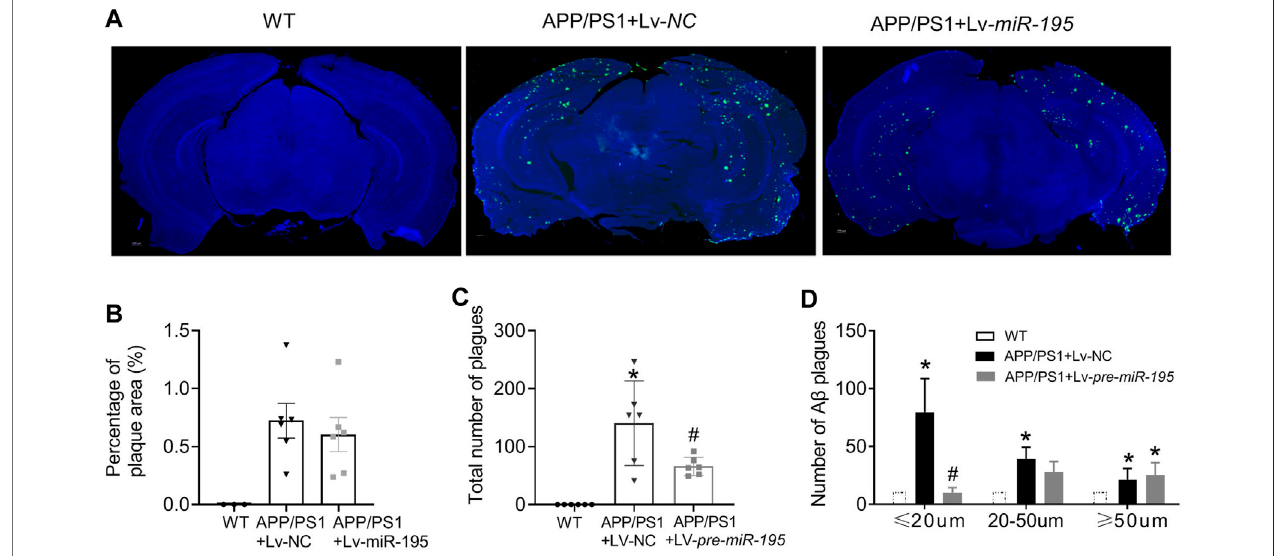
FIGURE 8 | MiR-195 reduces A β plaques in the brain of APP/PS1 mice (A) Representative confocal images showing the deposition of A β plaques in the brain of 7M-old WT mice, APP/PS1 mice with LV-NC injection and APP/PS1 mice with Lv-pre- miR-19 5 injection (B) The percentage ofA β plaquesarea in the brain ofAPP/PS1 mice* p < 0.05vs.WT (C) ThetotalnumberofA β plaquesinthebrainofAPP/PS1micewithbraininjectionofLv-pre -miR-195 for3M.* p < 0.05vs.WT.# p < 0.05vs.Lv- NC (D) MiR-195 has different effects on A β plaques based on different sizes (below 20 μ m, 20 – 50 μ m, above 50 μ m). * p < 0.05 vs. WT. # p < 0.05 vs.